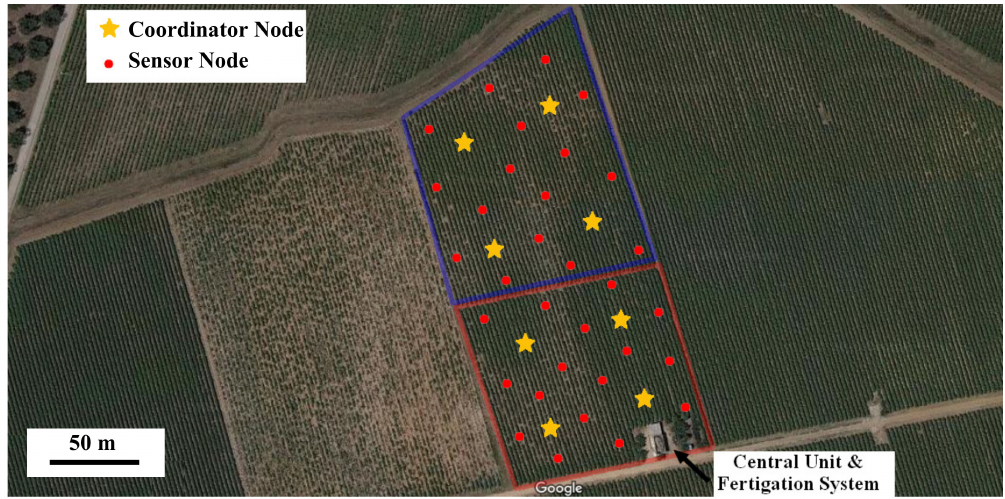
Figure 6. Distribution of the WSN sensor and coordinator nodes on the land cultivated with vineyards in the south of Italy (specifically north of Lecce city), divided into two sectors with area of one hectare